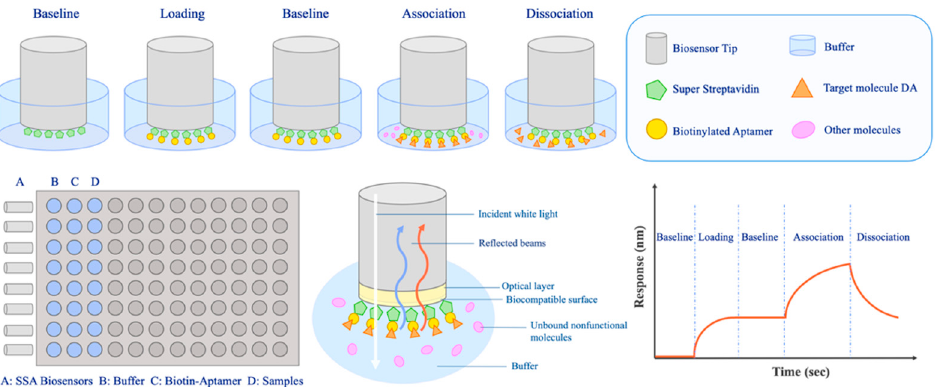
Figure 6. The working principle of biolayer interferometry.